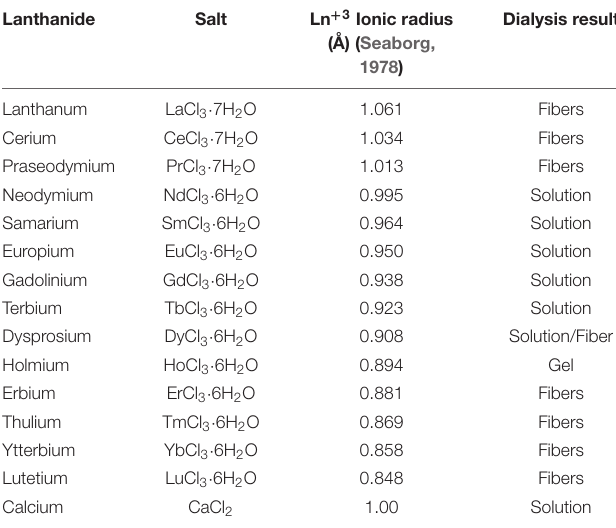
TABLE 1 | Lanthanide salts used for SF dissolution/regeneration protocol. For comparison, calcium chloride standard salt is listed in the last row. Lanthanide Salt Ln + 3 Ionic radius